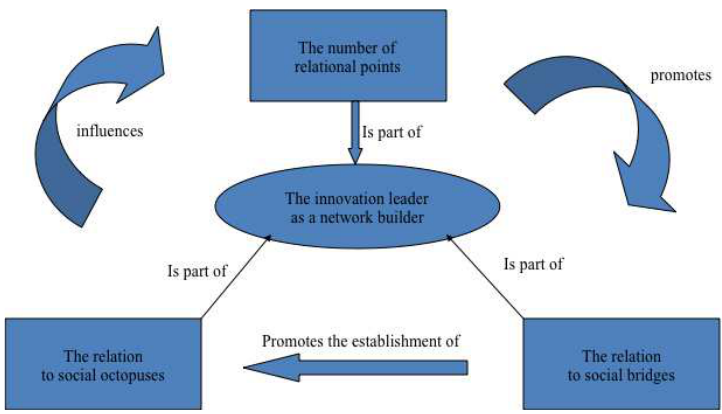
Fig. 4 The innovation leader as a network